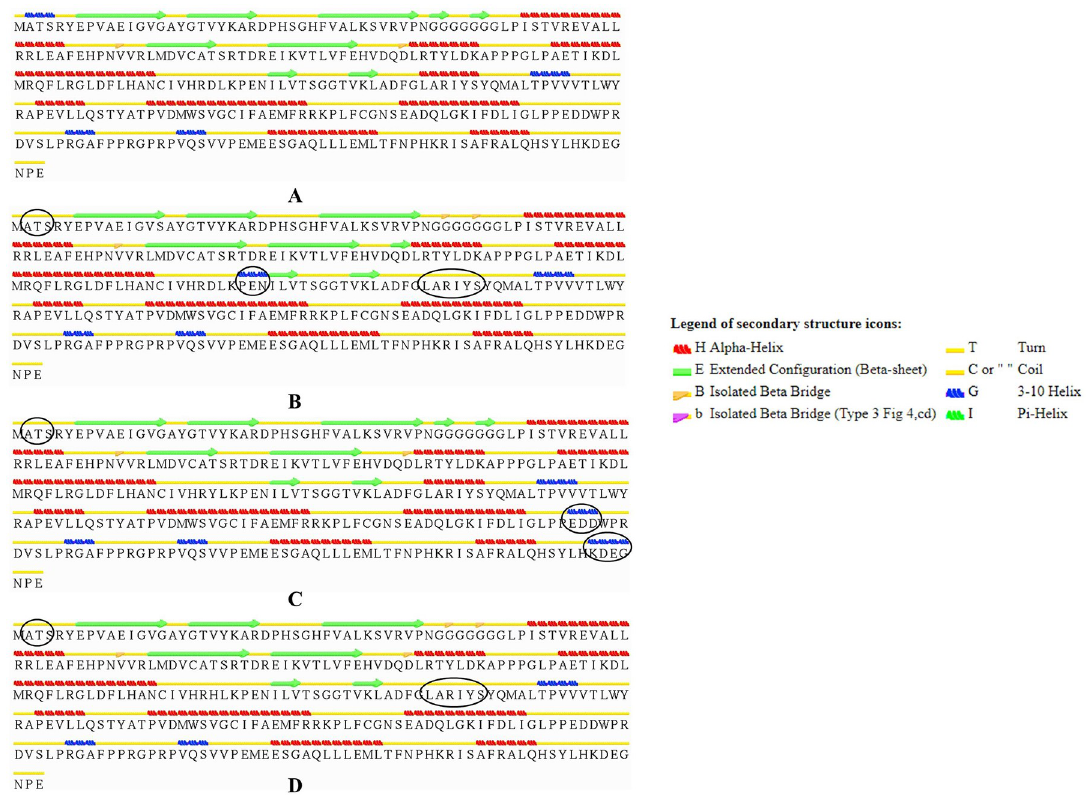
Fig 3. Secondary structure analysis of native and mutants by STRIDE program. Secondary structures elements of (A) native CDK4 (B) Mutant G15S (C) Mutant D140Y and (D) Mutant D140H protein. Changes in Structural elements are shown in circle.